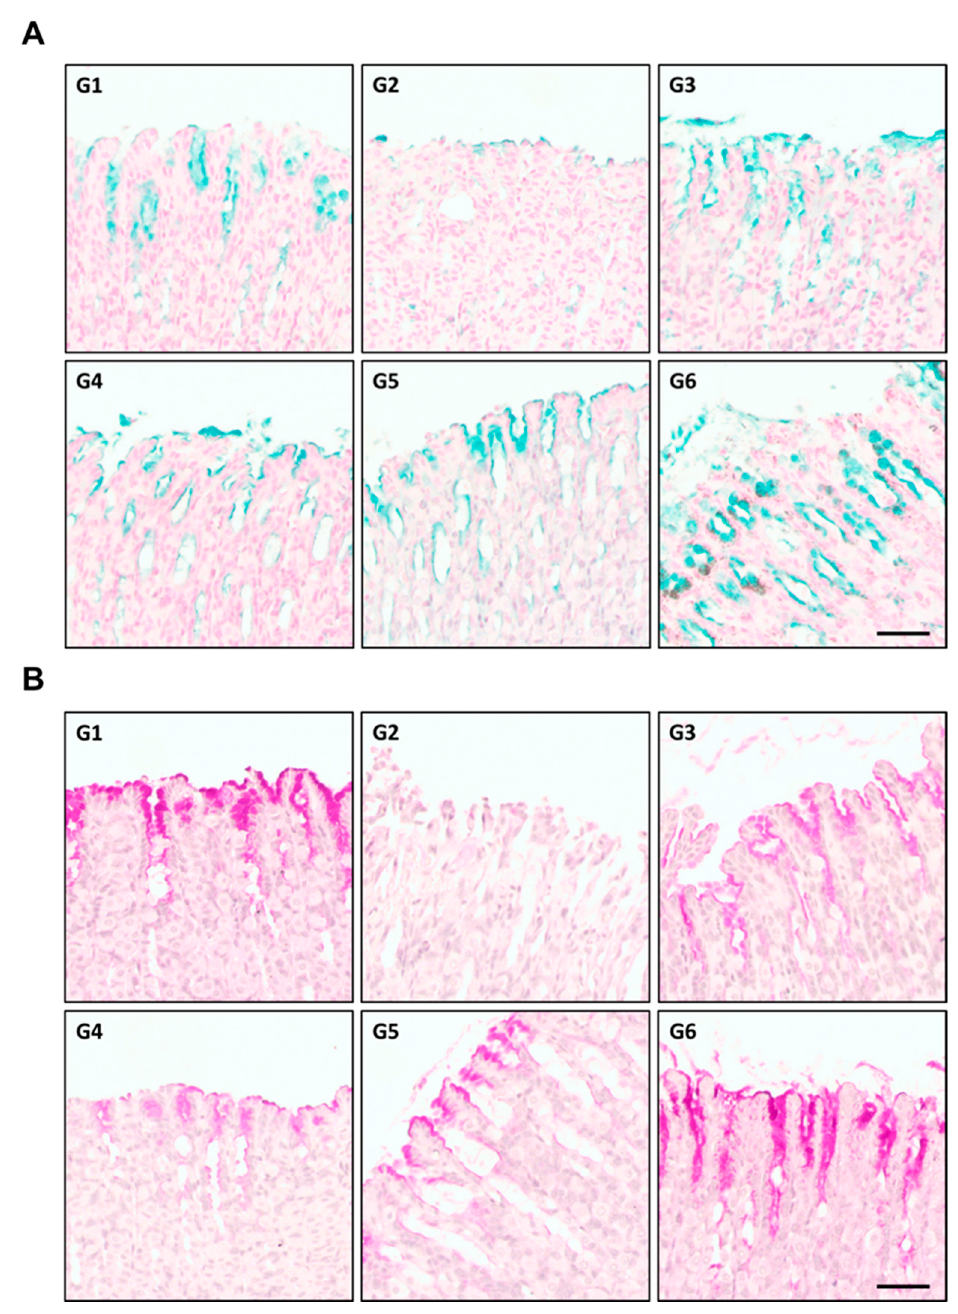
Figure 7. Alcian/periodic acid-Schiff staining of HCl-EtOH induced ulceration in rat stomach. Upper pictures (G1–G6): Alcian staining for acidic mucin, Lower pictures (G1-G6): Periodic acid-Schiff staining for acidic/neutral mucin; G1: Normal group, G2: HCl/EtOH treated group, G3: omeprazole, G4: beeswax alcohol 100 mg/kg G5: low-dose of RW0117 (25 mg/kg), G6: high-dose of RW0117 (50 mg/kg) (scale bar = 50 μ m). ( A ) Alcian blue staining of HCl-EtOH induced ulceration in rat stomach. ( B ) Periodic acid-Schiff staining of HCl-EtOH induced ulceration in rat stomach.